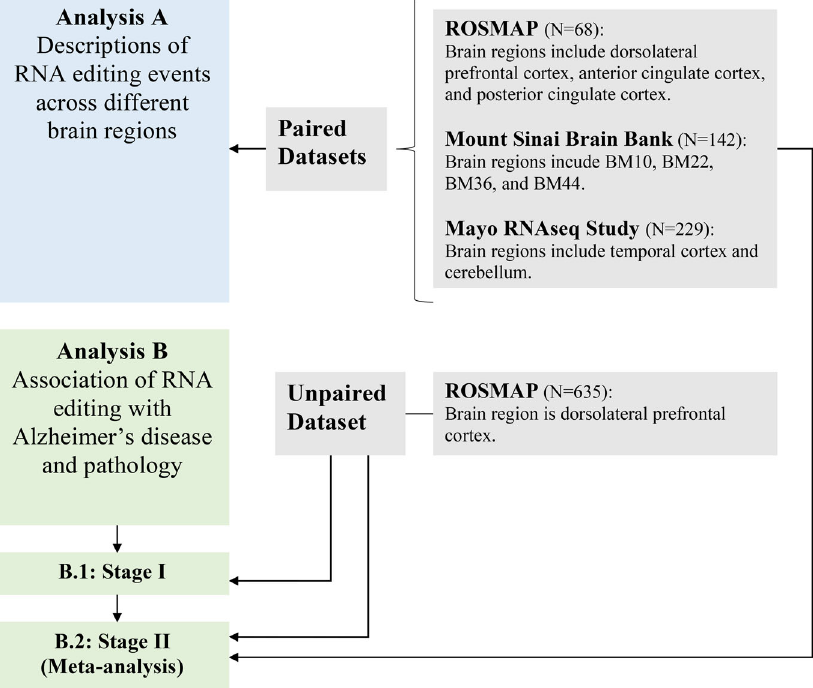
Fig. 1 Flow chart of our analyses. This diagram outlines the different datasets used in our report and the different analyses that were